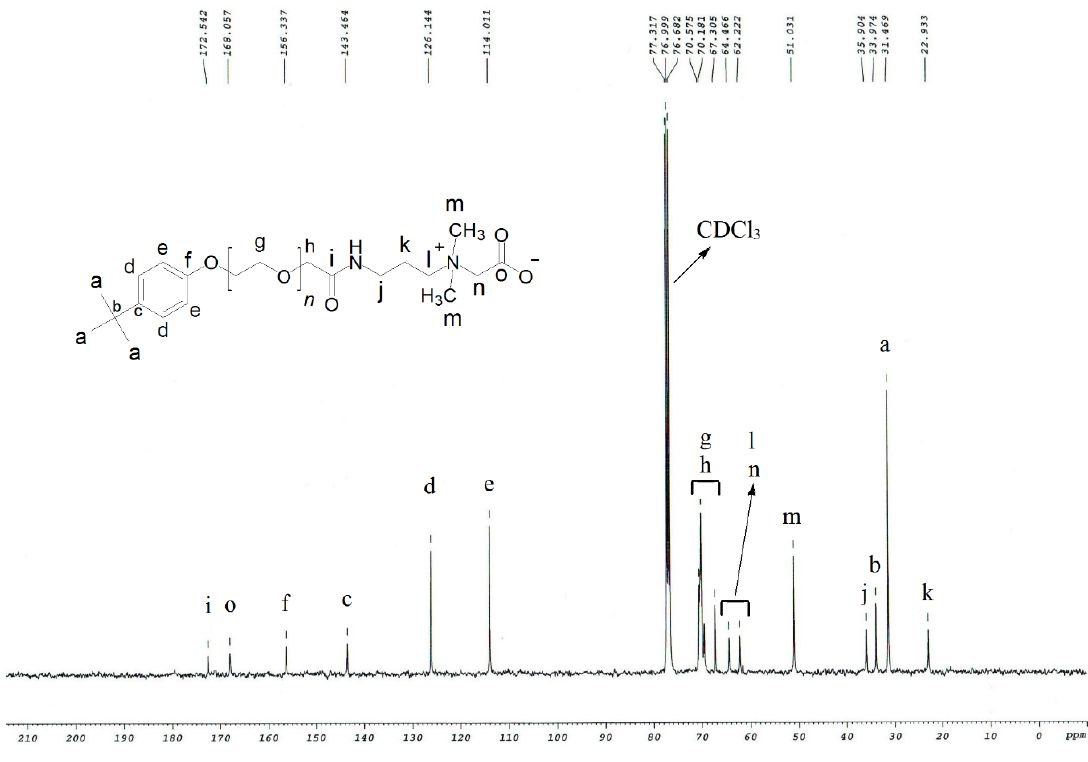
Figure 3. Carbon-13 NMR of TEAC. Table 2. 13 C NMR records displaying the values of chemical shift in zwitterionic surfactants.